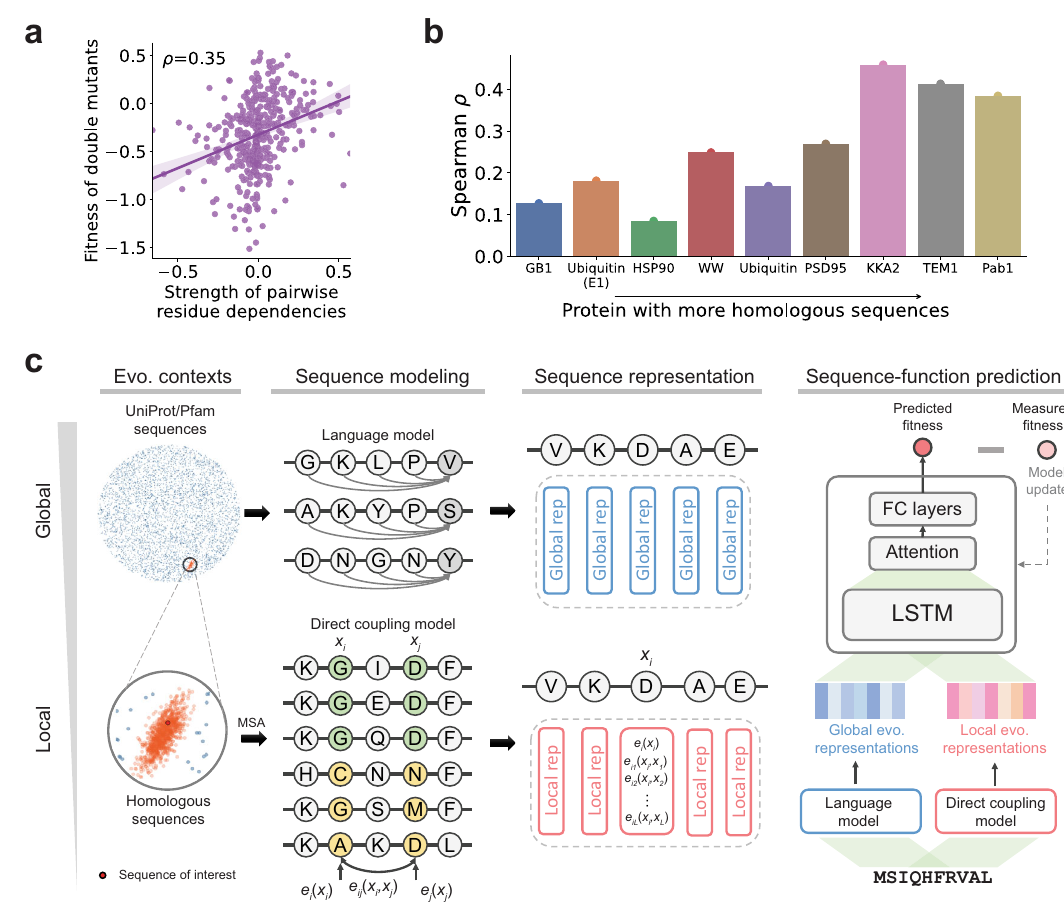
Fig. 1 The motivation and overview of our evolutionary context-integrated sequence modeling method for protein engineering. a Sequence co-evolution data correlates with fi tness measurements in deep mutational scanning studies. The scatter plot shows the relationship between the fi tness measurement of double mutants and the co-variation strength of residues where the mutations were introduced. Each data point represents a double mutant. The error band indicates the 95% con fi dence interval of the regression line. b Sequence co-evolution data can be used to predict protein fi tness. The bar plot shows the Spearman correlation between experimentally measured fi tness and strength changes of co-variation. Proteins were sorted by the number of homologous sequences. c An overview of ECNet, our evolutionary context-integrated deep learning framework for protein engineering. ECNet integrates global and local evolutionary contexts to represent the protein sequence of interest. First, a language model is used to learn global semantic-rich global sequence representations from the protein sequence databases such as UniProt or Pfam. Next, a direct coupling analysis model is used to capture the dependencies between residues in protein sequences, which encodes the local evolutionary context. The global and local evolutionary representations are then combined as sequence representations and used as the input of a deep learning model that predicts the fi tness of proteins. Quantitative fi tness data measured by deep mutational scanning (DMS) are used to supervise the training of the deep learning model (MSA: multiple sequence alignment; Dim. reduction: dimensionality reduction; LSTM: long short-term memory network; FC layers: fully-connected layers; Evo. contexts: evolutionary contexts; Evo. representations: evolutionary representations; Global/Local rep: global/local measured by deep mutational scanning). We used the LSTM neural network architecture and trained protein-speci fi c models using large-scale deep mutational scanning datasets ( “ Methods ” ). representations, with one accounting for residue interdependen- general sequence semantics in the protein universe. Existing tools amino acid independently (e.g., PolyPhen-2 36 and CADD 37 ) while others exploit structure information (e.g., FoldX 38 and OSPREY 39 ). However, the functions of proteins are often driven by the interdependencies between residues (e.g., epistasis) in the protein 40,41 , and not all the protein structures are solved. We thus explicitly modeled the pairwise interactions of all pairs of sites in a protein by extracting signals of evolutionary conservation from its homologous sequences or sequence families. We used a generative graphical model, fi tted on the multiple sequence